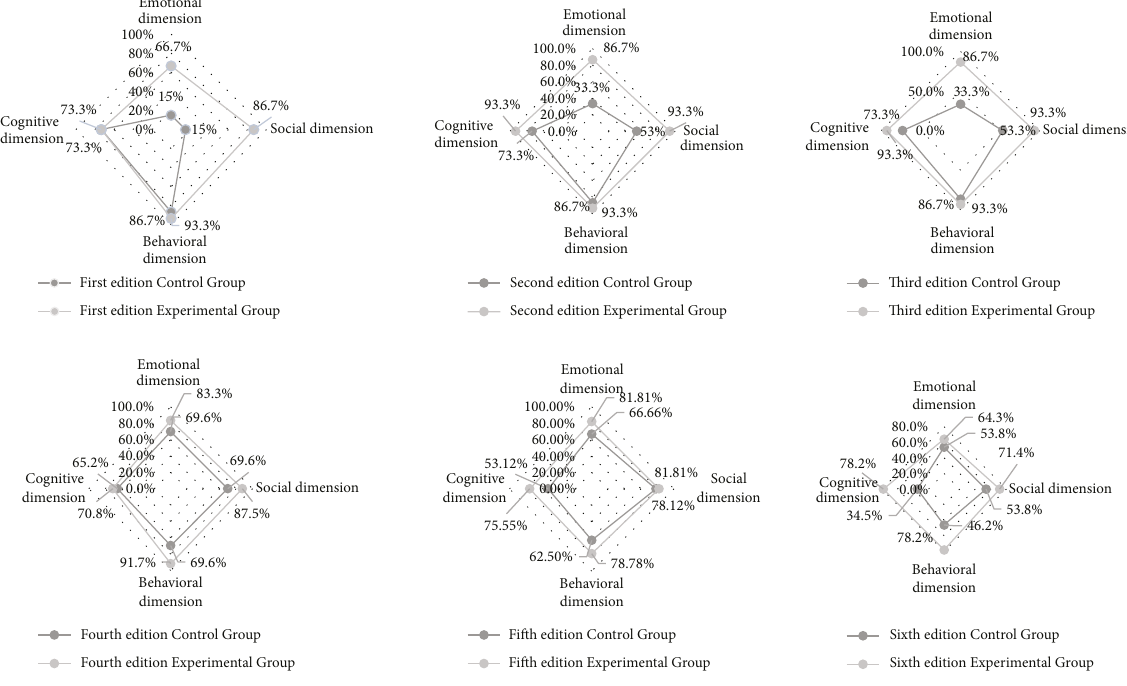
Figure 6: Posttest: development of the engagement